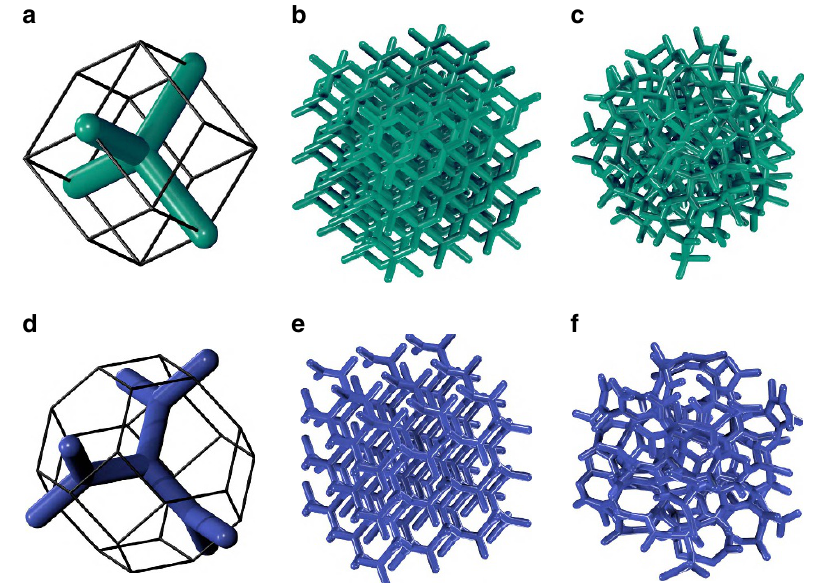
Figure 1 | Strongly isotropic networks and their amorphous derivatives in three dimensions. The WS cell of a diamond PhC ( a ) contains a 1-tree of dielectric material (green); the edges of the tree define a tetrahedral unit. Stacking of the WS cells generates the champion diamond PhC ( b ). Amorphous diamond ( c ) consists of deformed tetrahedral units connected in a CRN. Similarly, the WS cell of a single-network gyroid PhC contains a 2-tree ( d ), comprising dielectric material (blue), in which each vertex is a trihedron. When stacked, the WS cells generate a single-network gyroid PhC with a near- champion PBG ( e ). Amorphous gyroid ( f ) comprises deformed trihedral units connected in a